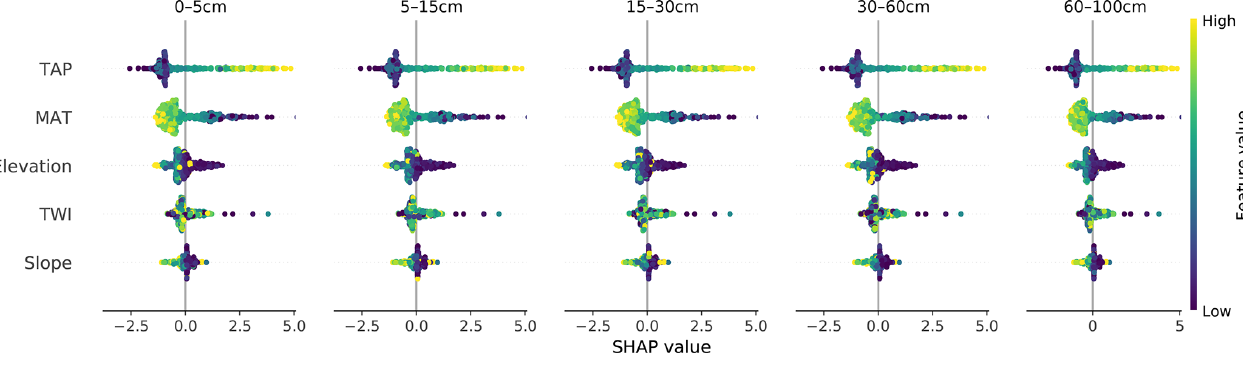
Figure 4. SHAP values for each covariate and soil depth interval for the CNN model. TAP: total annual precipitation; MAT: mean annual temperature; TWI: topographic wetness